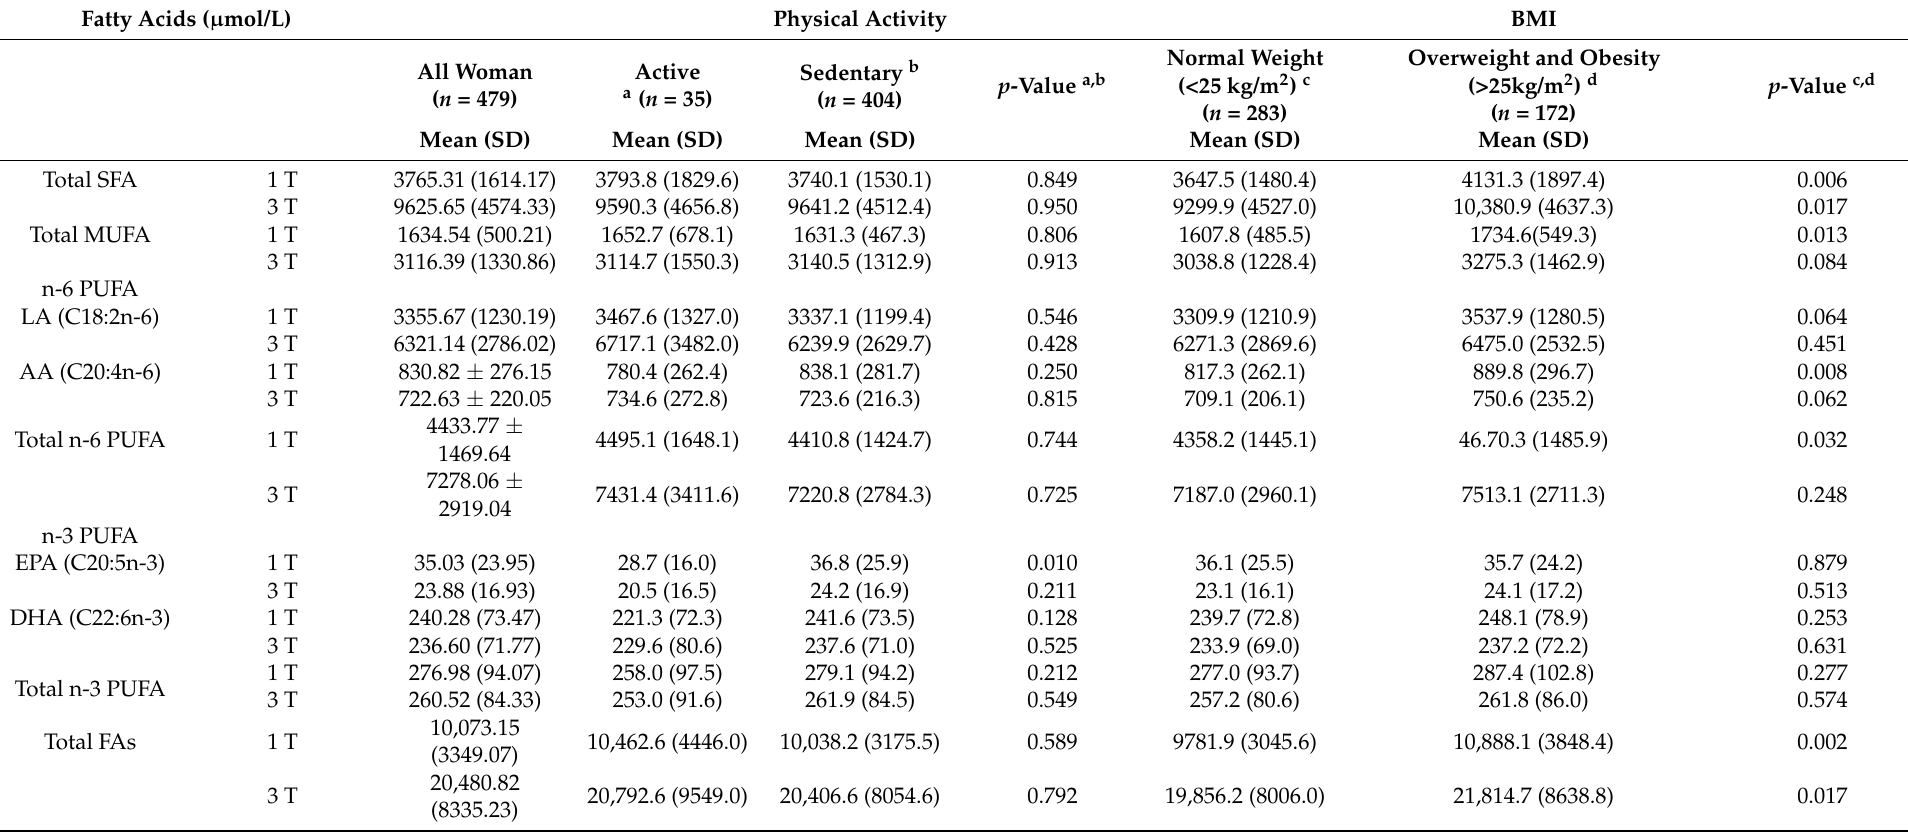
Table 2. Fatty acids serum profile during the first (T1) and third (T3) trimester of pregnancy according to maternal